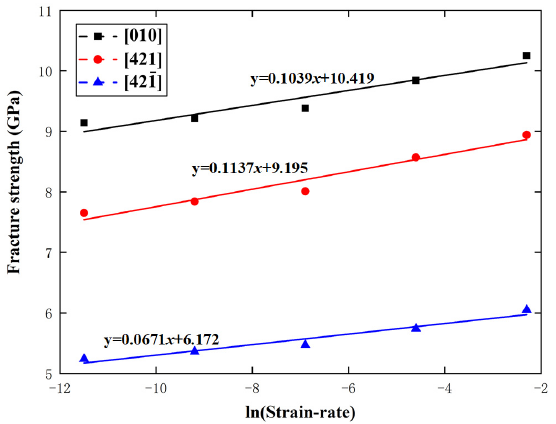
Figure 15. Variations of fracture strength with logarithmic strain rate along the [010] , [421] , and [421] directions.